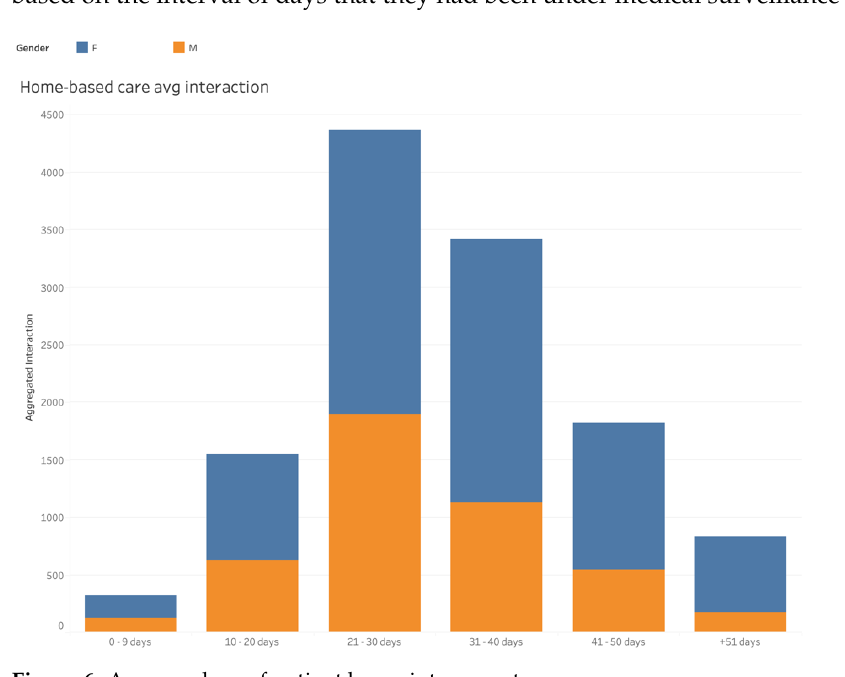
Figure 6. Average days of patient home internment.